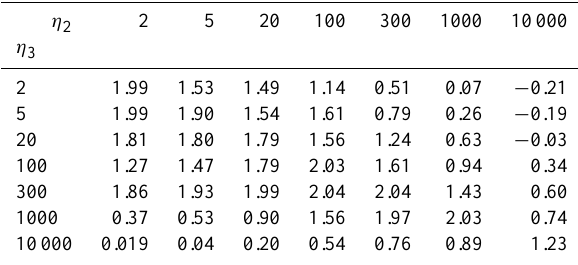
Table A3. Tangent of the slope of the curve showing the depen- dence of the logarithm of L 2 -error for velocity component v y on the logarithm of the grid step for different viscosity contrasts. Lin- early varying